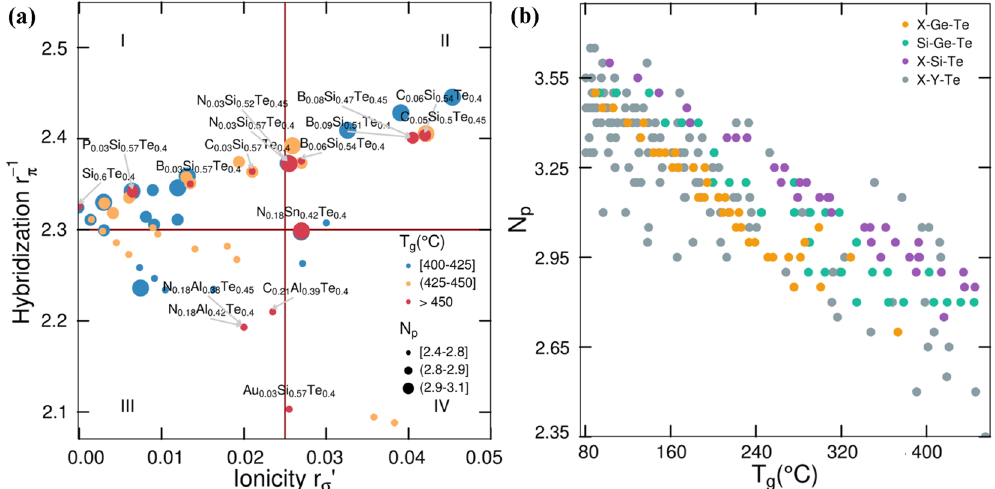
Figure 6. Computed thermal stability of predicted materials exhibiting OTS. ( a ) The glass transition temperature ( T g ) is used as a monitor of thermal stability. Labels are added to the compositions with T g > 450 °C. The size of the points is proportional with N p . Zone IV is depopulated and the materials with the highest thermal stability are situated in zones I and II. ( b ) The average number of p -electrons as a function of T g . A clear correlation is observed, the average number of p -electrons decreases with increasing thermal